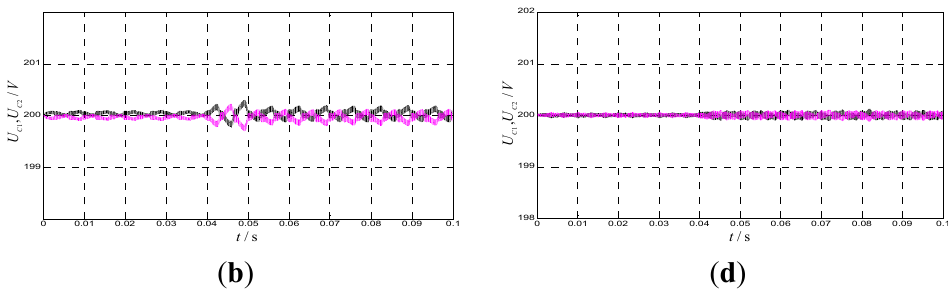
Figure 4. Simulation results of varying load. ( a ) response of the currents to varying load in VSVM; ( b ) capacitors voltage during varying load in VSVM; ( c ) response of the currents to varying load in VVSVM; ( d ) capacitors voltage during varying load in VVSVM.